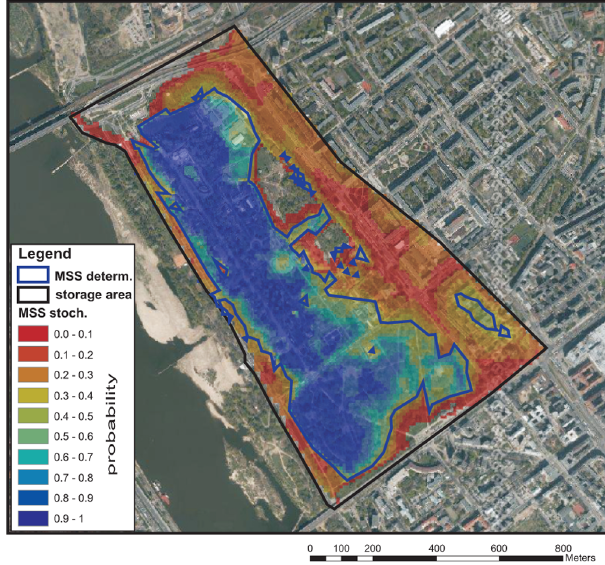
Fig. 6. Comparison of flood inundation extent for a 1-in-100 yr flow for four scenarios: (a) Goclaw; (b) ZOO; (c) Goledzinow; (d) in- bank zone; perpendicular red dashed lines represent simulated de- terministic inundation extent. Mean stochastic values are shown by black dashed lines.